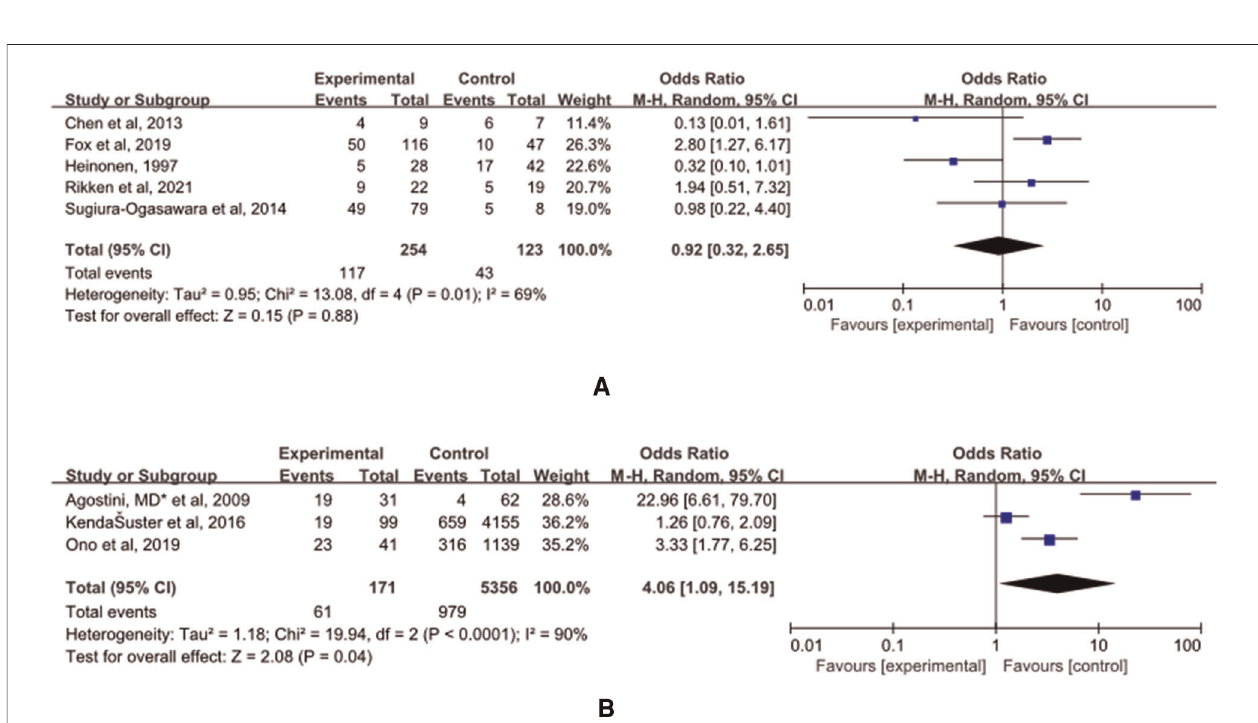
FIGURE 7 | The effect of hysteroscopic metroplasty on malpresentations. ( A ) The control group of untreated women with septum uterus, and the study group was patients who underwent hysteroscopic surgery. ( B ) The control group of these articles was women with intact uterus, and the study group was patients who underwent hysteroscopic surgery.